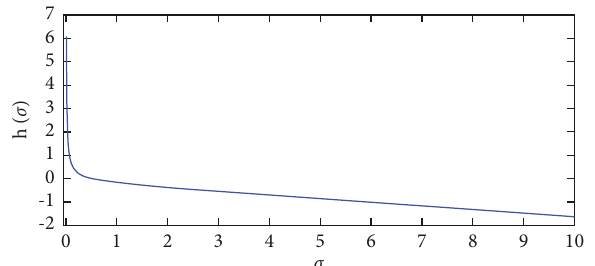
g σ σ σ with respect to σ ( ) (cid:31) ( ) −